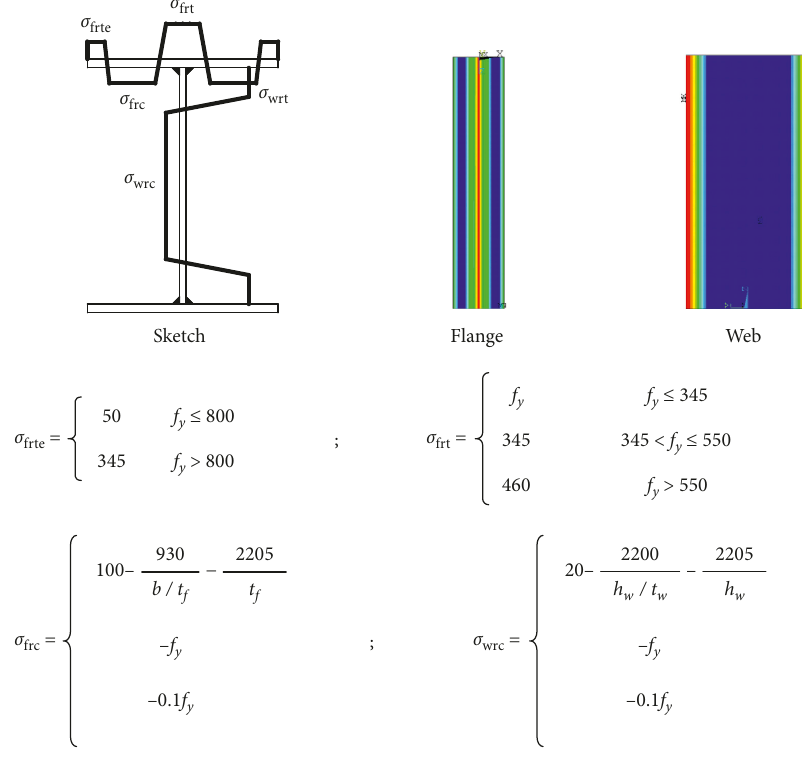
Figure 3: Residual stress pattern